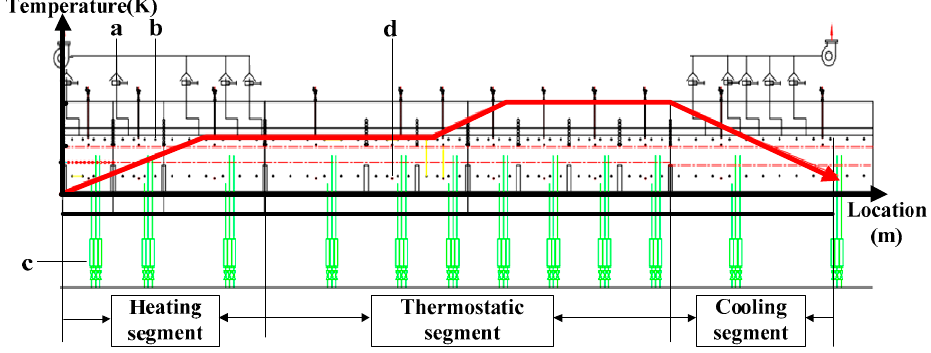
Figure 3. Structure diagram of sintering furnace for battery sintering.